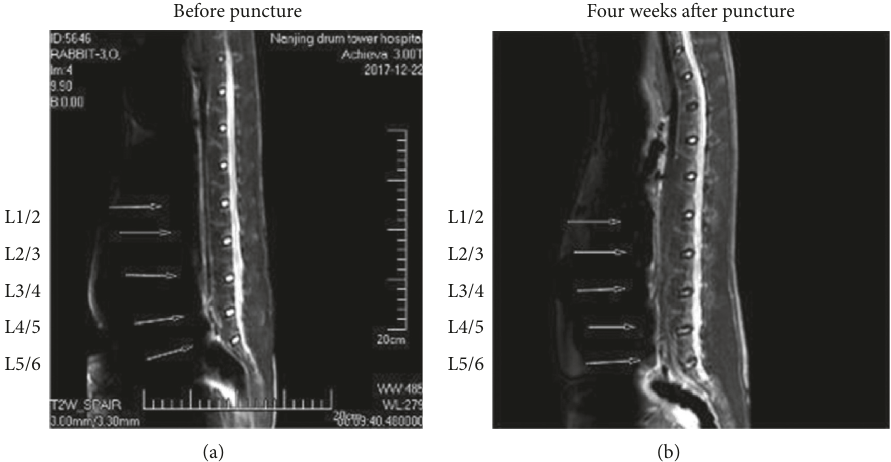
Figure 2: The signal of intervertebral discs (L2/3, L3/4, L4/5, and L5/6) in magnetic resonance (MR) T2-weighted images appeared to be significantly lower in (b) compared with (a), while in intervertebral discs L1/2, magnetic resonance images showed no difference on T2- weighted images.